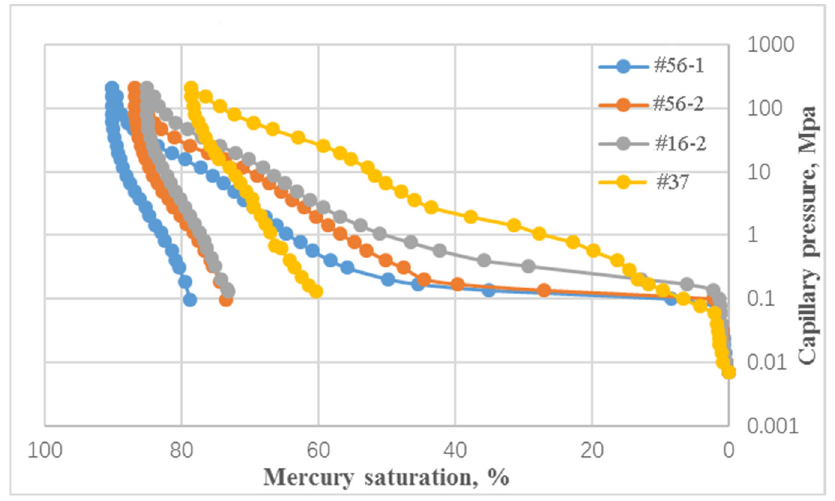
Figure 4. Capillary pressure curves comparisons.